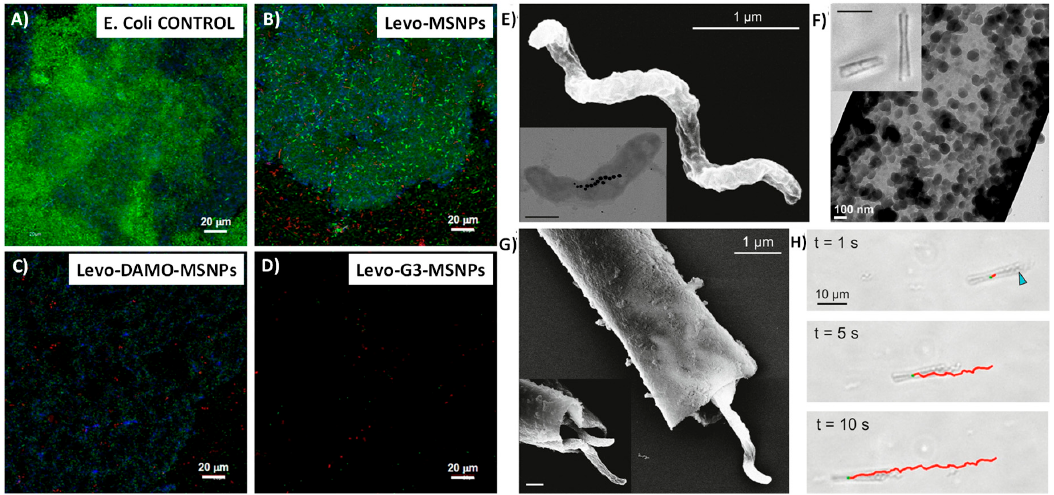
Figure 10. ( A–D ) Confocal microscopy study of the antimicrobial activity of the Levo-loaded MSNPs materials onto Gram-negative E. coli biofilm. Live bacteria are stained in green, dead bacteria in red, and the matrix biofilm in blue (adapted with permission from [91], copyright Elsevier Ltd., 2017). ( E – H ) Characterized bacteria-driven biohybrid micro-swimmers. ( E ) SEM image of MSR-1 bacterium. Inset displays TEM of MSR-1 and the internal magnetosome chain. Inset scale bar = 500 nm. ( F ) TEM image of pores in MSMi. Inset displays bright field microscopy images of long and short MSMi. Inset scale bar = 10 µm. ( G ) SEM of MSR-1 cells captured within a microtube. Inset displays increased magnification of bacteria in the tube. Inset scale bar = 500 nm. ( H ) Bright field microscopy images of MSR-1-powered biohybrids swimming. Blue arrow indicates location of MSR-1 inside the microtube. Red track indicates the trajectory of the biohybrid (adapted with permission from [186], copyright American Chemical Society 2017). Table 5. Mesoporous Silica Nanoparticles for the Treatment of the Formed Biofilm. Targeting Molecule